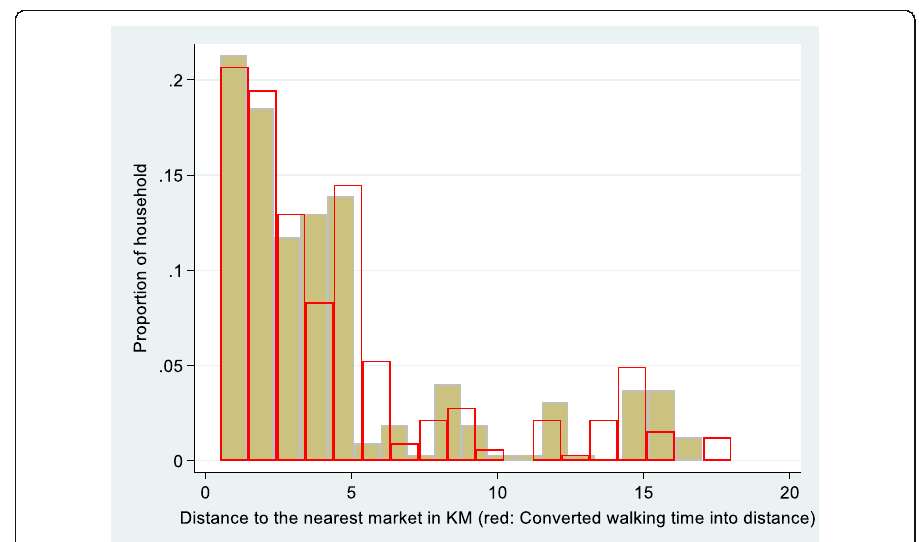
Fig. 7 Distances to markets are measured by both distance and time. Source: Authors ’ computation using